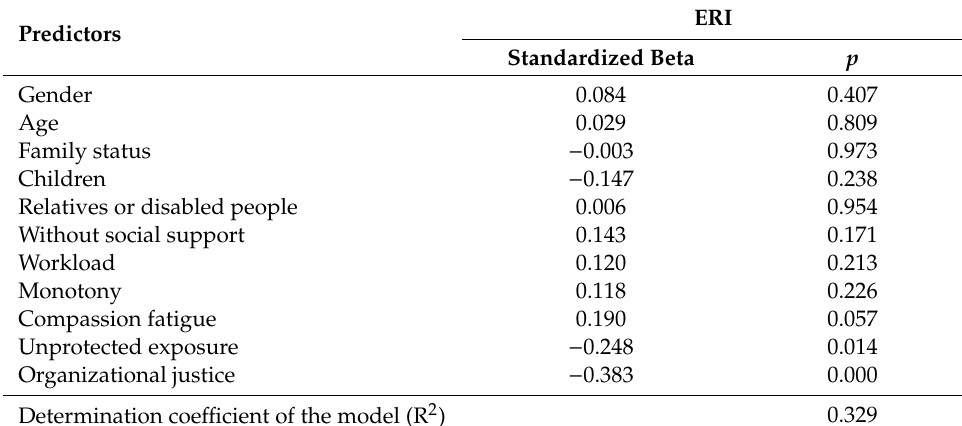
Table 3. Linear regression analysis. Relationship between socio-demographic factors, work changes, organizational justice and perceived work-related stress (ERI).